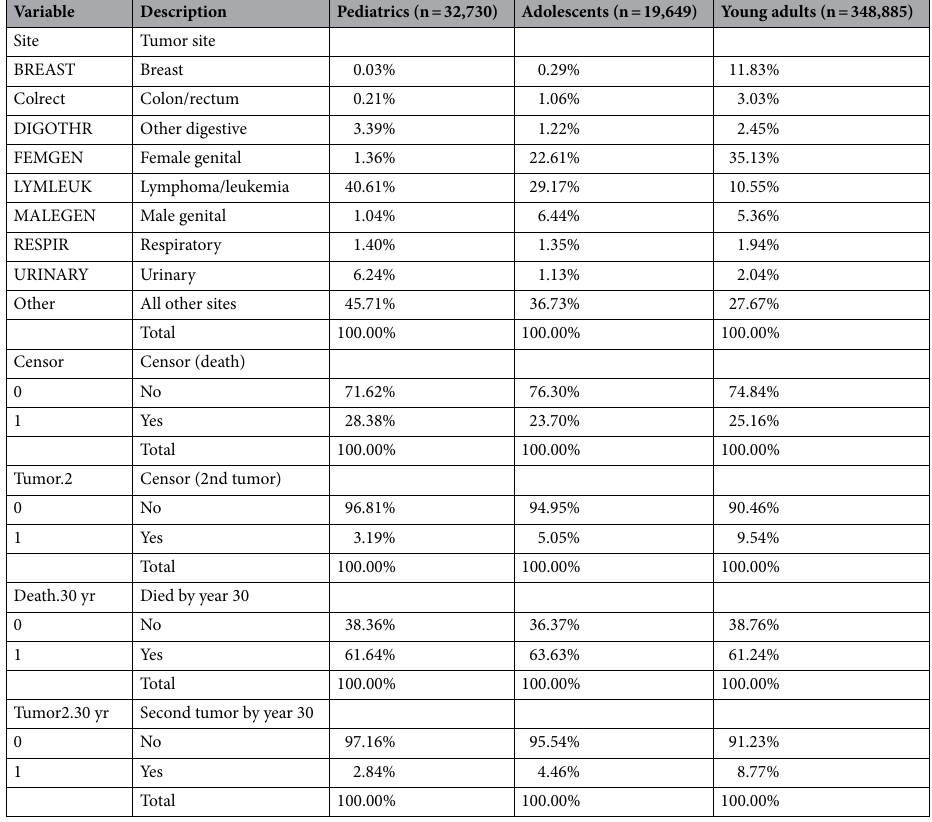
Table 1. Data distribution by age